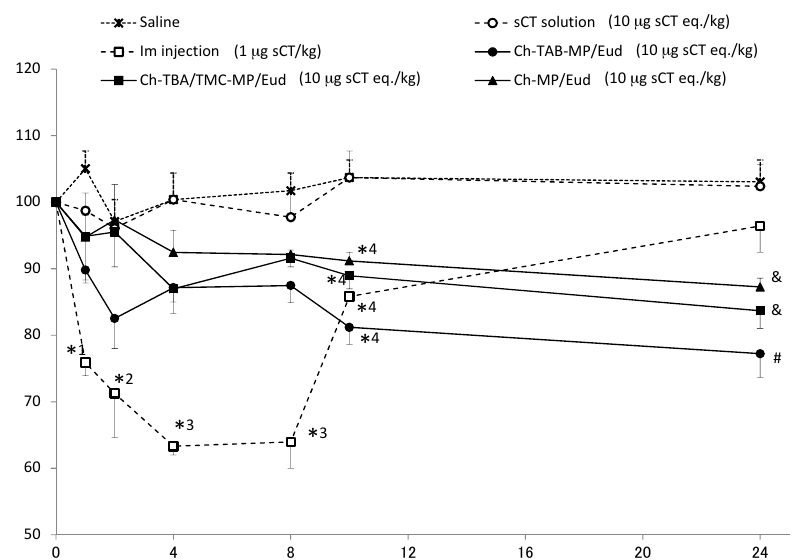
Figure 4. Plasma Ca levels after the intragastric administration of each preparation to rats. The initial level, defined as the level immediately before administration, was set to 100%. Each point represents the mean ± standard error of mean (S.E.M.) ( n = 3). * 1 p < 0.05 vs. saline, sCT solution, Ch-TBA/TMC-MP/Eud, Ch-MP/Eud; * 2 p < 0.05 vs. saline, Ch-MP/Eud; * 3 p < 0.05 vs. saline, sCT solution, Ch-TBA-MP/Eud, Ch-TBA/TMC-MP/Eud, Ch-MP/Eud; * 4 p < 0.05 vs. saline, sCT solution; # p < 0.05 vs. saline, sCT solution, im injection; & p < 0.05 vs. saline, sCT solution (Tukey’s test).